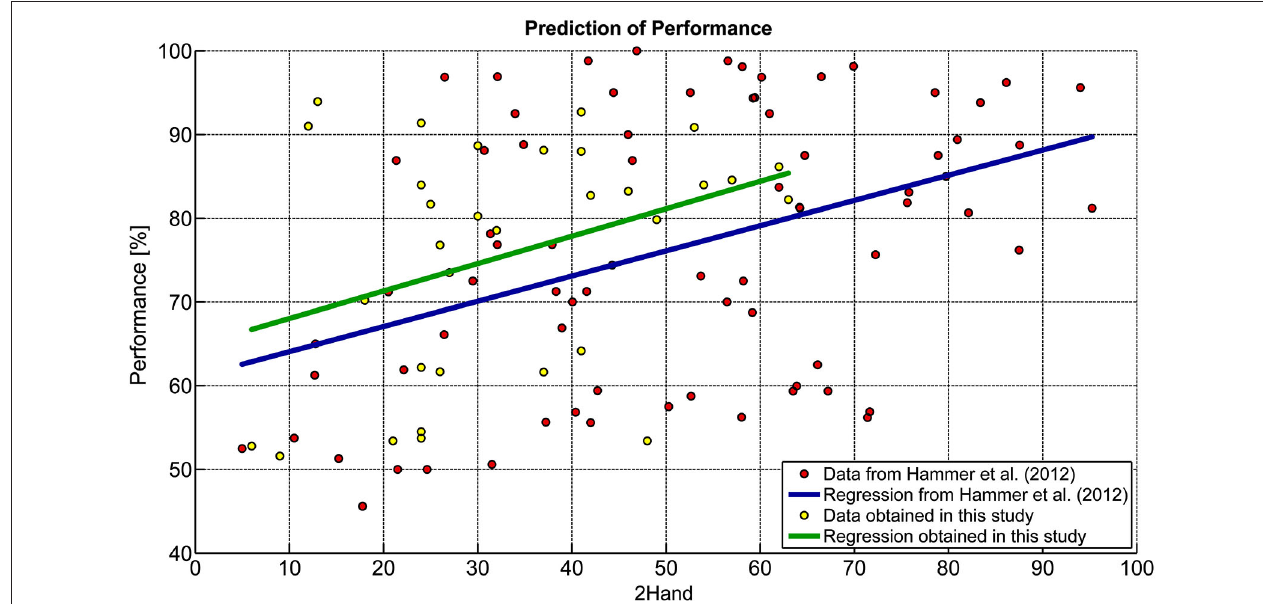
FIGURE 2 | Comparison of prediction models. Data from Hammer et al. (2012) were compared to those obtained in this study.